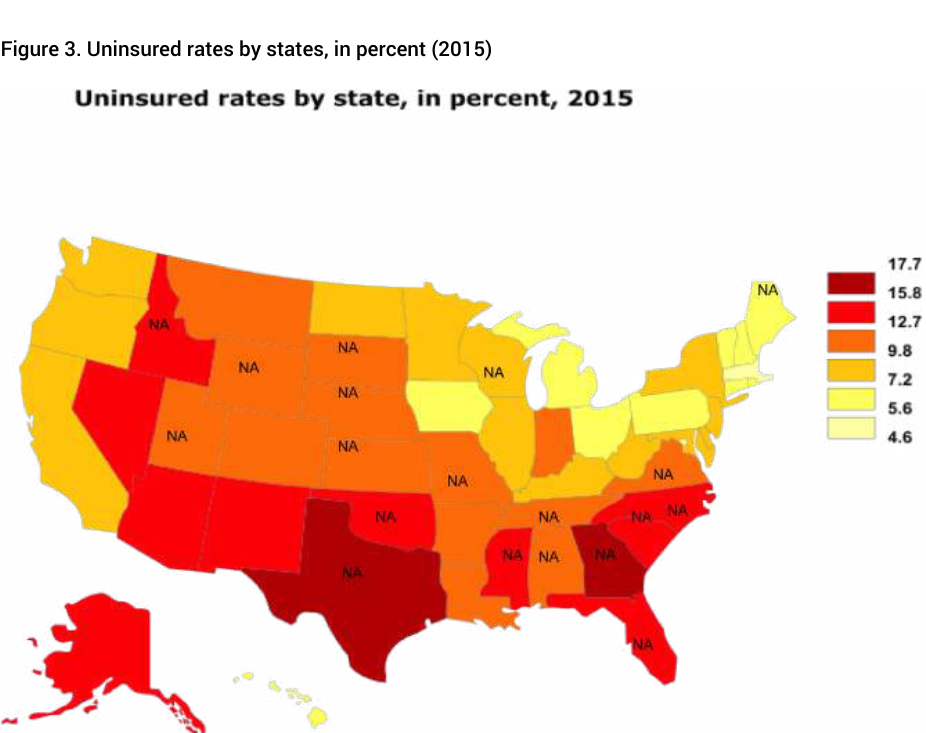
Adapted from the Kaiser Family